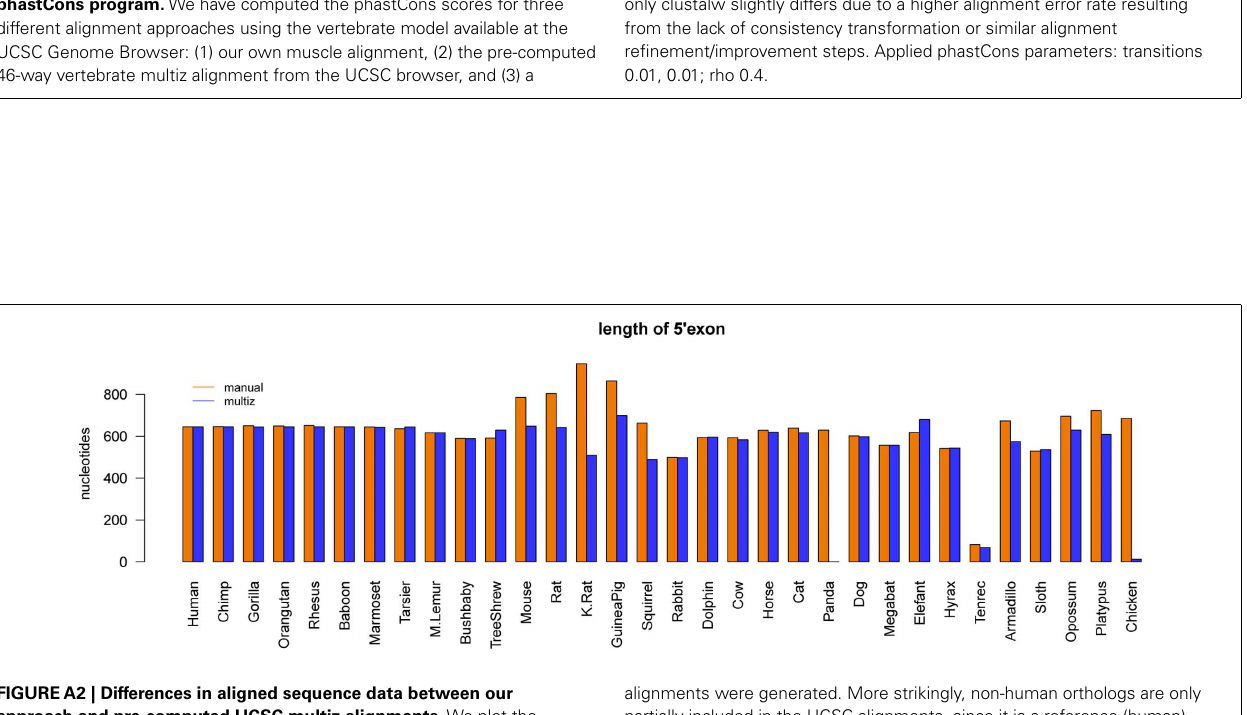
FIGUREA2 | Differences in aligned sequence data between our approach and pre-computed UCSC multiz alignments. We plot the sequence portion of the 5 (cid:2) -exon of EGO-B for different species and alignment approaches.There is a large overlap but also substantial differences between the two alignment approaches. An obvious drawback of pre-computed alignments is missing data. For example, the UCSC alignments do not contain the ortholog of panda because the assembly was not ready at the time the